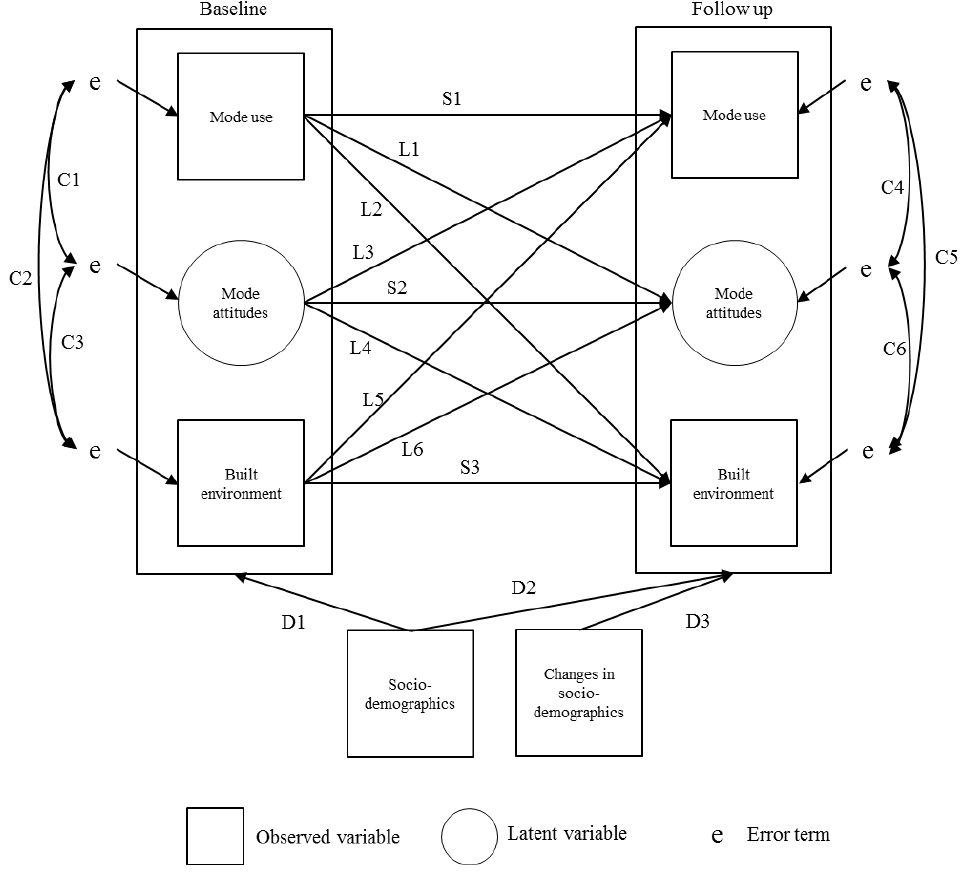
Figure 3. Specification of the cross-lagged panel